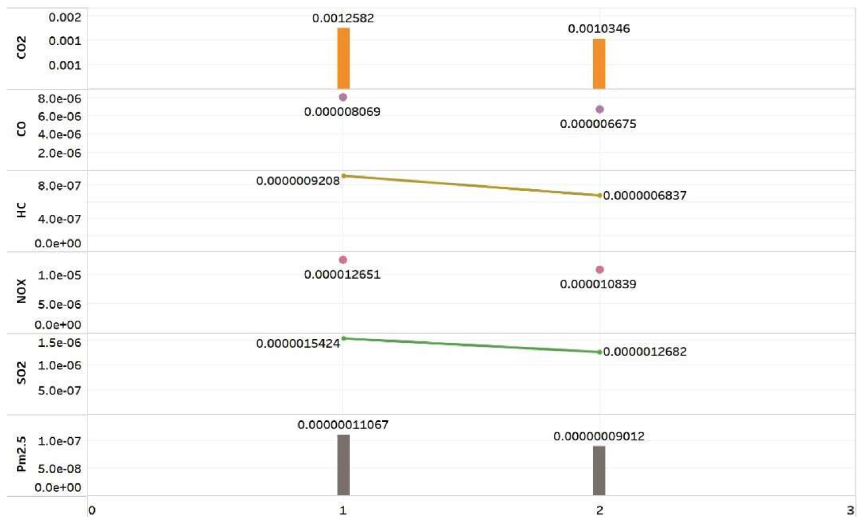
Figure 6. Changes in average unit turnover emissions of six pollutants before and after the CNG2020 strategy was proposed (tonnes).